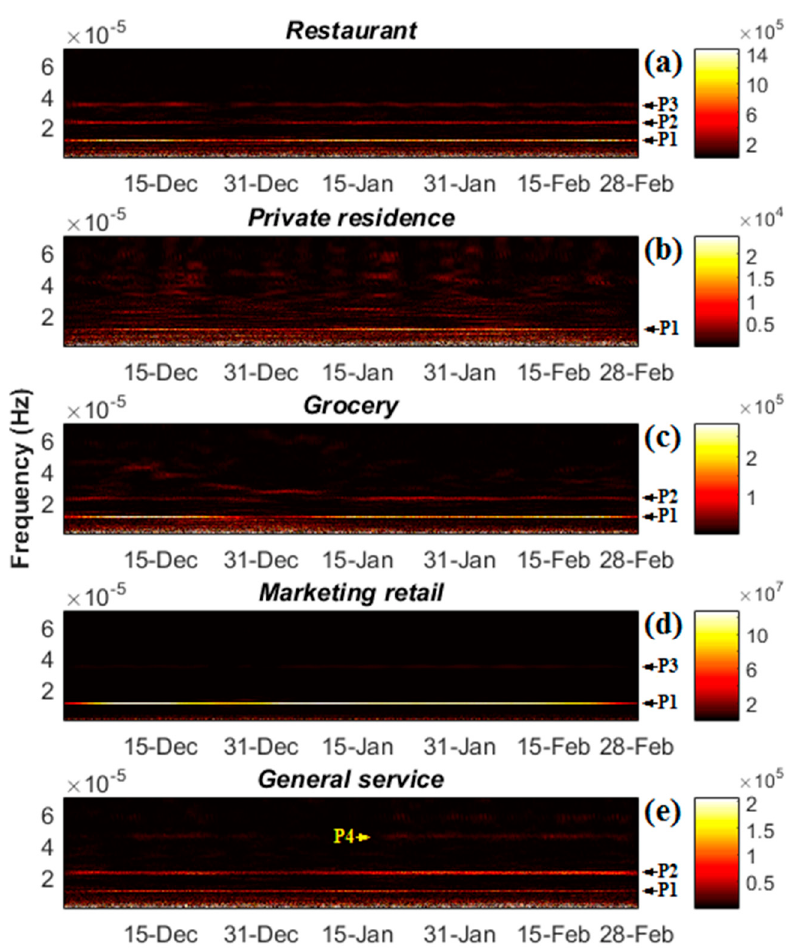
Figure 6. Wavelet scalogram of the reactive power for ( a ) a restaurant; ( b ) a private residence; ( c ) a grocery; ( d ) a marketing retail establishment; ( e ) a general service.